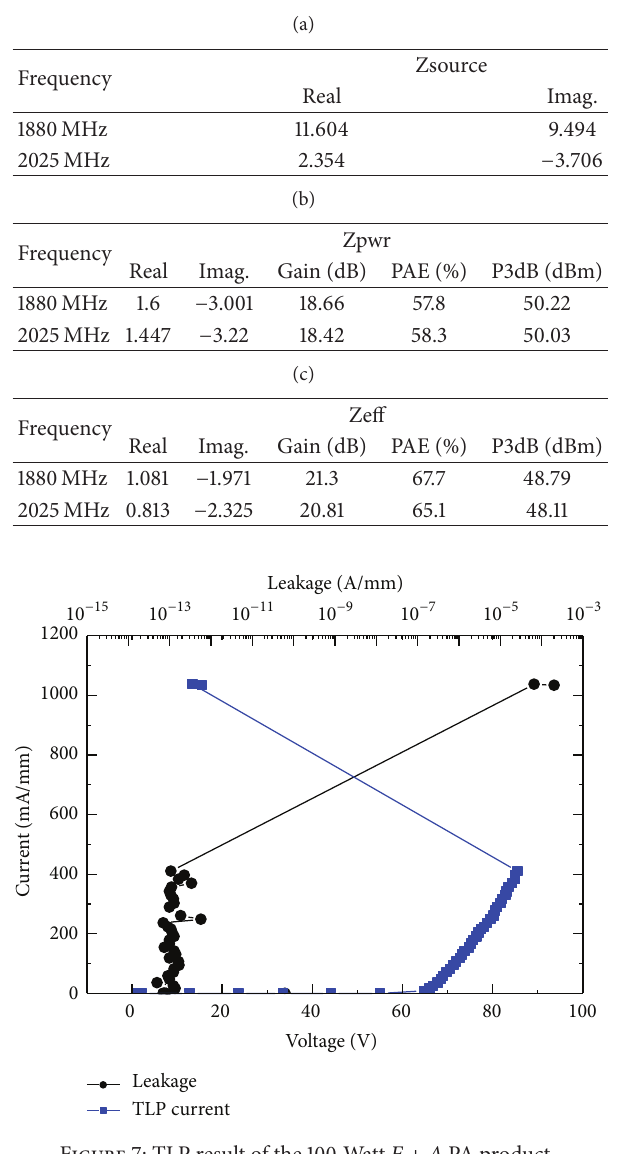
Figure 7: TLP result of the 100-Watt 𝐹 + 𝐴 PA